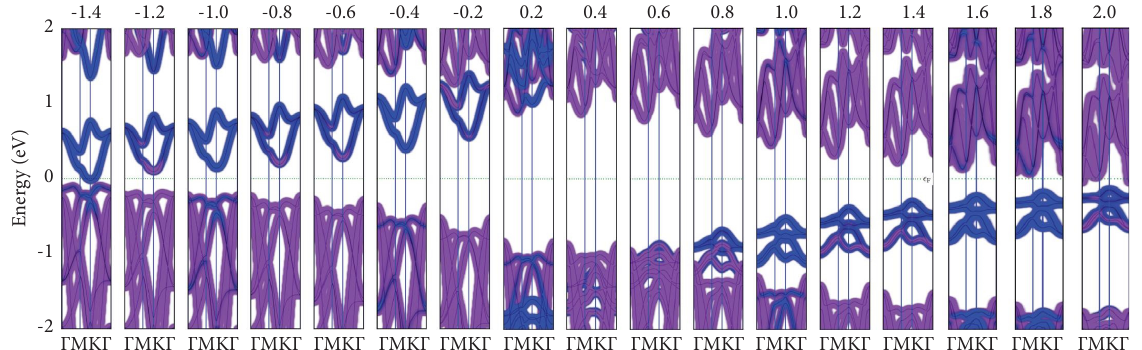
Figure 5: Band structures of the CTF/As vdWhs under the electric felds with a 0.2V/˚A